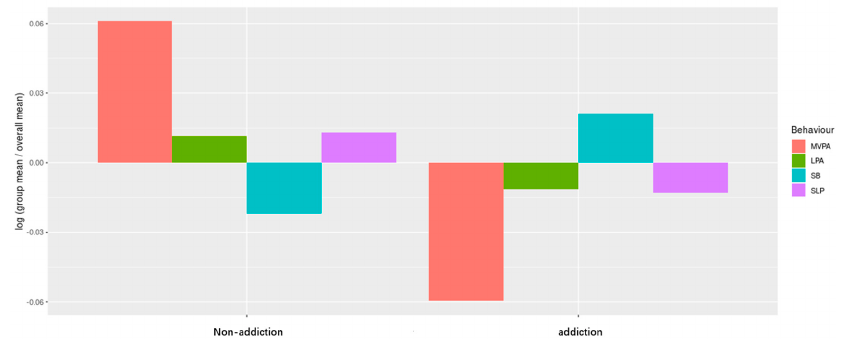
Figure 1. Comparison of 24-Hour movement behaviors of participants by group. SLP, sleep duration; SB, physical activity; LPA, light-intensity physical activity; MVPA, moderate-intensity physical activity.